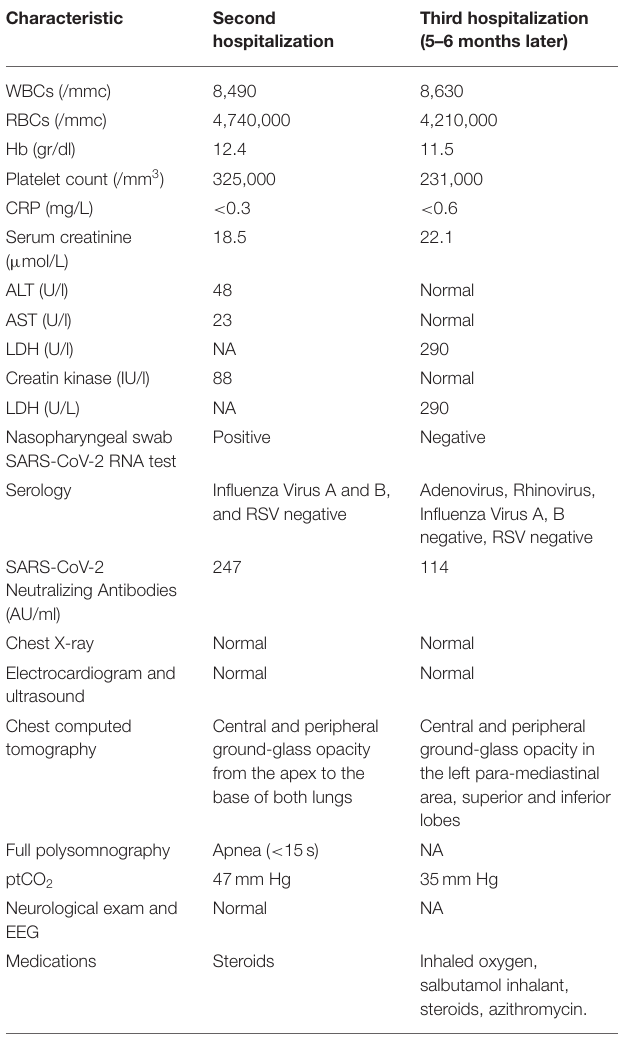
TABLE 1 | Findings of blood and diagnostic exams performed on hospital admission and follow-up.